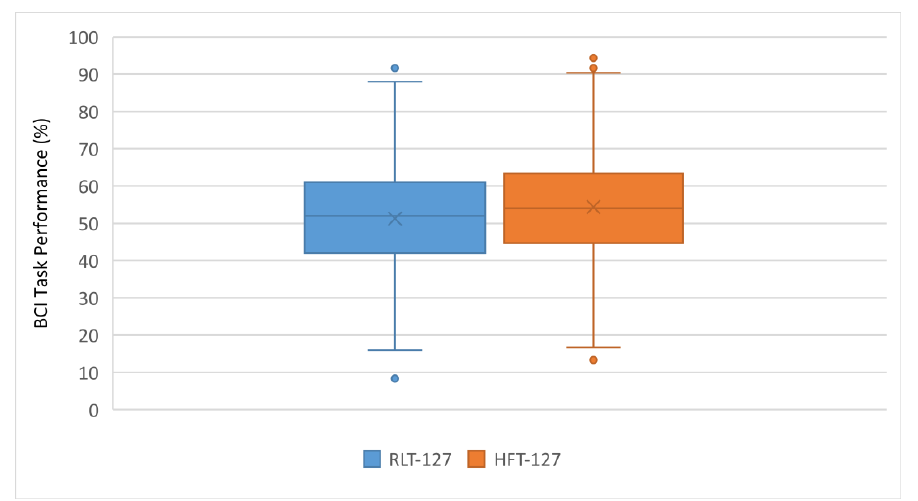
Figure 8. Individual task performance for RLT vs. HFT.